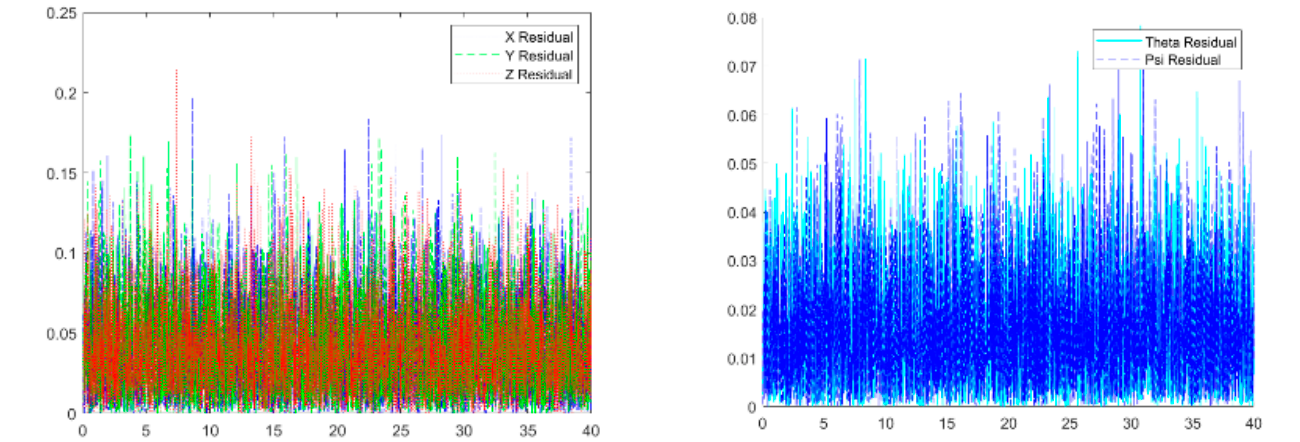
Figure 5. Residual values for the sensors.